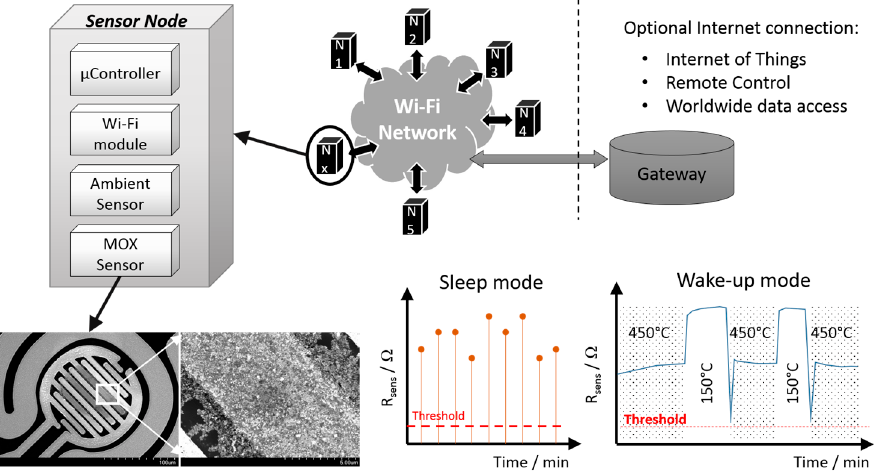
Figure 2. Concept of the wireless odor sensing network: A CuO based MEMS chip is used as central building block to enable the highly selective detection of H 2 S, which is used as indicator for the amount of bad odor. In the sleep mode the system checks periodically whether or not a bad odor event has occurred. Once this has happened, the sensor node switches into measurement mode and determines the H 2 S concentration based on the percolation time. All sensor node data are transmitted to the internet where data regarding spatial and temporal distribution of bad odors may be analyzed.